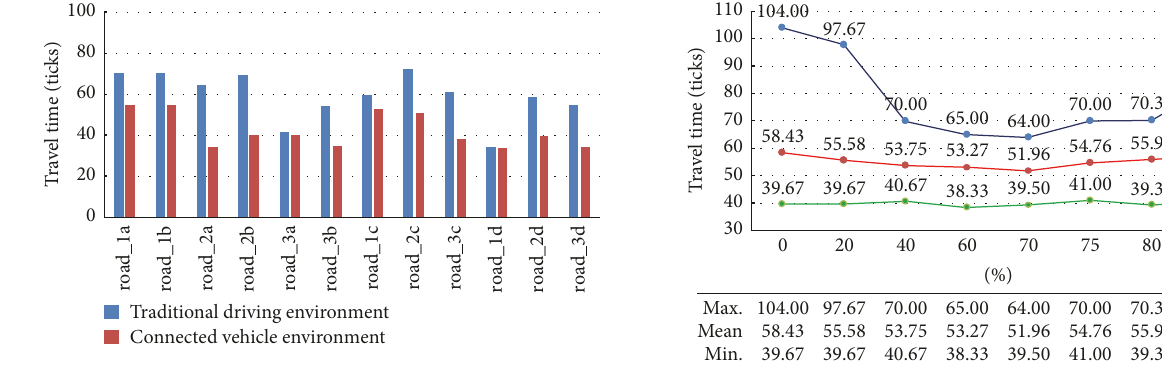
Figure 9: Mean value of travel time under the connected vehicle environment.